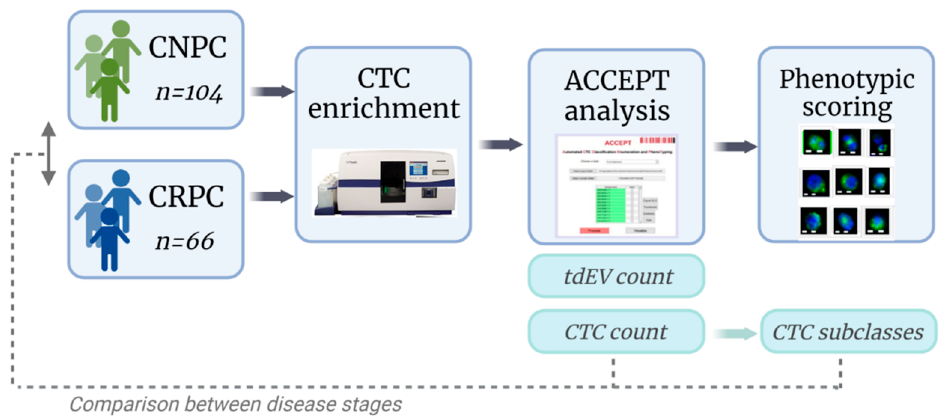
Figure 1. Overview of patient inclusion, CTC enrichment, CTC and tdEV enumeration, phenotypic scoring, and classification of CTCs. Made with Biorender.com.